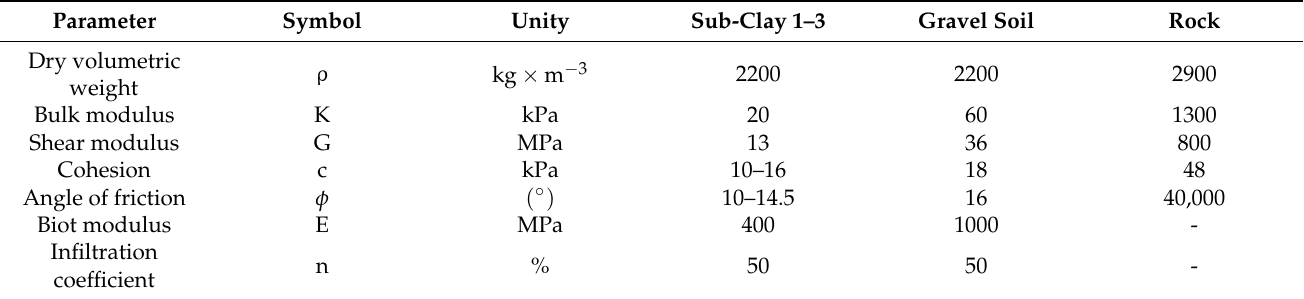
Figure 2. The numerical mesh model of the study site. Table 1. Summary of the main characteristics of the materials.